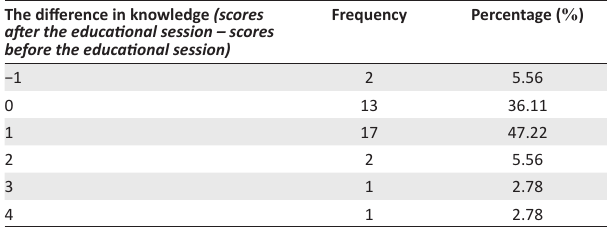
TABLE 4: Difference in knowledge before and after the educational session.